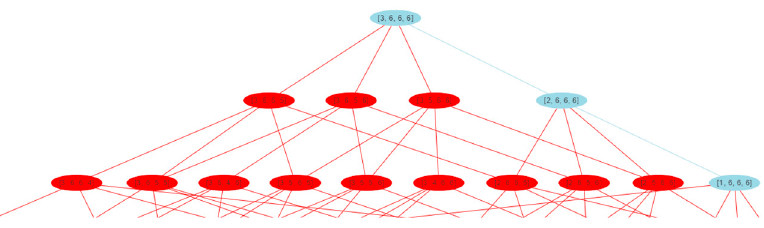
Figure 17. Safe Solutions (Blue).